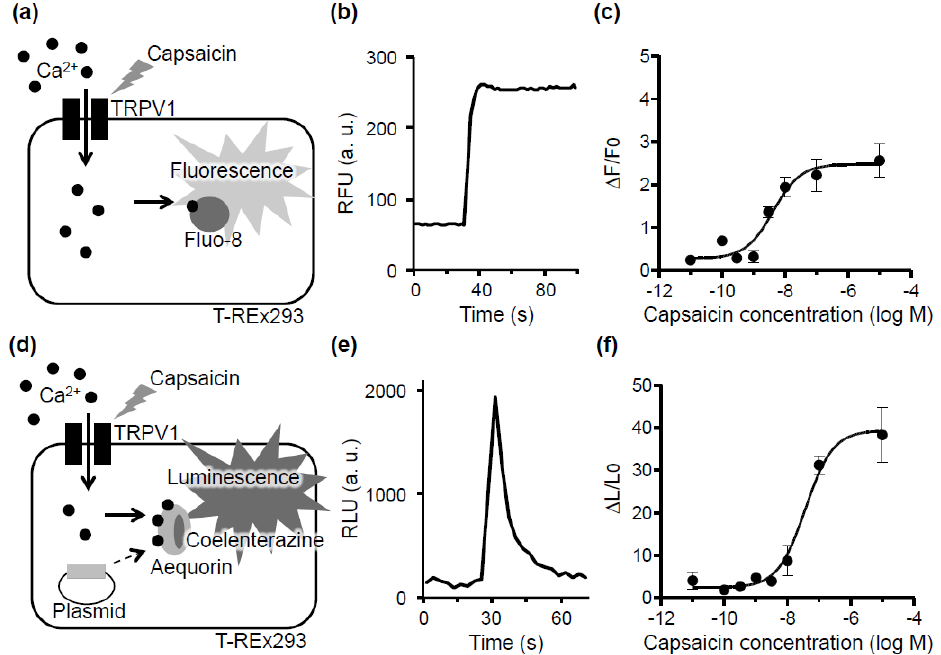
Figure 2. Comparison of measured human transient receptor vanilloid 1 (hTRPV1) activity for fluorescence- and luminescence-based assays. ( a , d ) Mechanism underlying the cell-based hTRPV1 assay system for the fluorescence ( a ) and luminescence ( d ) methods. Increased intracellular Ca 2+ concentration induced by hTRPV1 activation is detected as fluorescent or luminescent signals. ( b , e ) Representative Ca 2+ responses elicited by 10 nM capsaicin in the fluorescence ( b ) and luminescence ( e ) assays. ( c , f ) Concentration–response curves for capsaicin on hTRPV1 obtained in the fluorescence ( c ) and luminescence ( f ) methods. Data are presented as the average ( n = 3) ± SE (error bars) in ( c , f ).